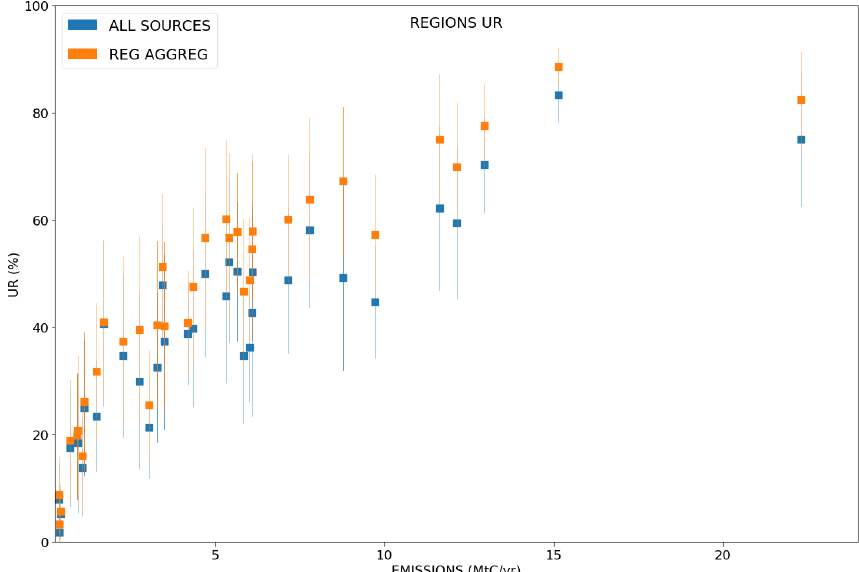
Figure A2. Mean values of the uncertainty reductions (UR) of the emissions at the regional scale across the 62 inversion results for the days of March and May 2016. Results are given as a function of the annual emissions ( x axis). Regional emissions are inverted with (blue markers) and without (orange markers) considering an internal separation of the region into cities, point sources or countryside